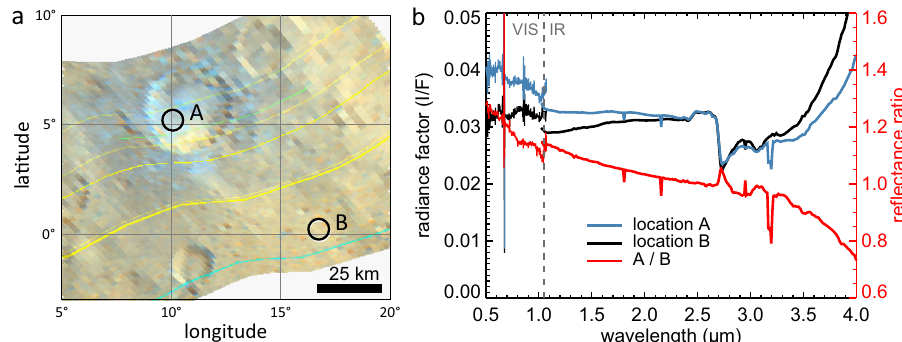
Fig. 2 Bluing in Haulani crater. a A map of Haulani and its surroundings from VIR cube 494731110 (red: 2.25 μ m, green: 1.75 μ m, blue: 1.25 μ m). We derived the average re fl ectance in two encircled locations with 8 km diameter: (A) inside the crater and (B) at some distance. b Re fl ectance spectra of the areas A and B and their ratio. The phase angle of observation ( α = 33°) was the same at both locations within 1°. Data below and above 1.05 μ m were acquired with separate detectors (VIS and IR). The IR spectrum was calibrated with corrections from ref. 54 . Remaining calibration artifacts, visible as yellow and cyan coloured lines in the colour composite and narrow spikes in the spectra, do not affect the spectral slope.